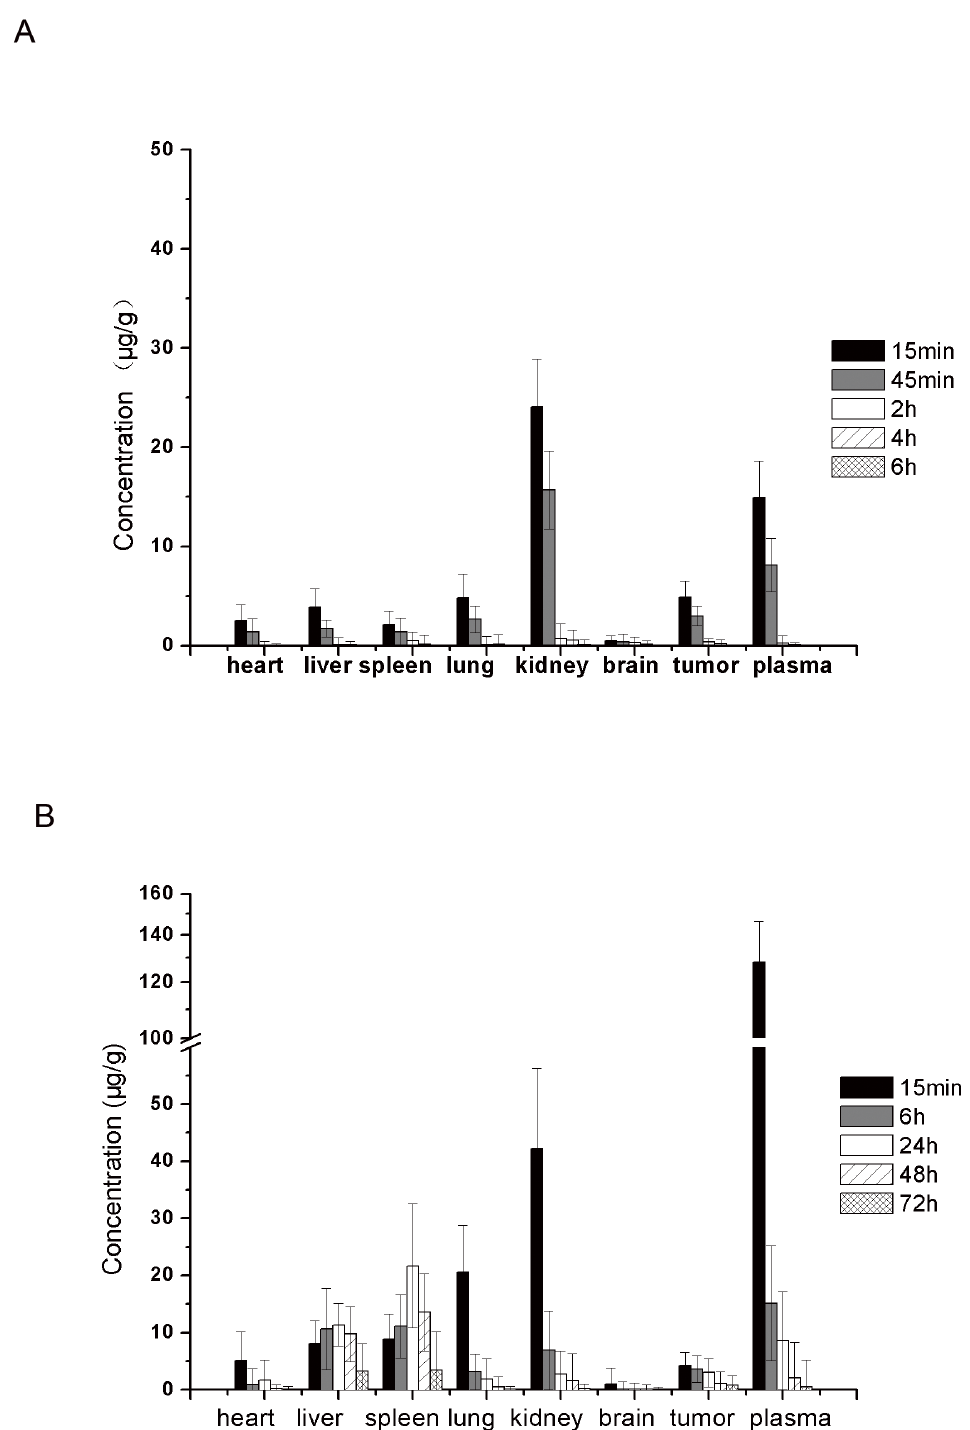
Figure 4. Biodistribution of 5-FA (A) and 5-FA-PAE (B) after i.v. injection. The tumor-bearing animal model was established by subcutaneous injection of H22 cells into Kunming mice. The control group and the test groups were administered intravenously with 20 mg/kg of 5-FA or 5-FA-PAE (equivalent to 20 mg/kg of 5-FA), respectively. The mice were exsanguinated and sacrificed at predetermined time points. Tissues (heart, liver, spleen, lung, kidney, brain and tumor) were collected, weighed and homogenized with two fold concentrated physiological saline. The samples of the test group were treated as hydrolyzed samples, whereas those of the control group were treated as unhydrolyzed samples. All data are presented as the concentration of 5-FA. Each value represents the mean 6 standard deviation (n=6).